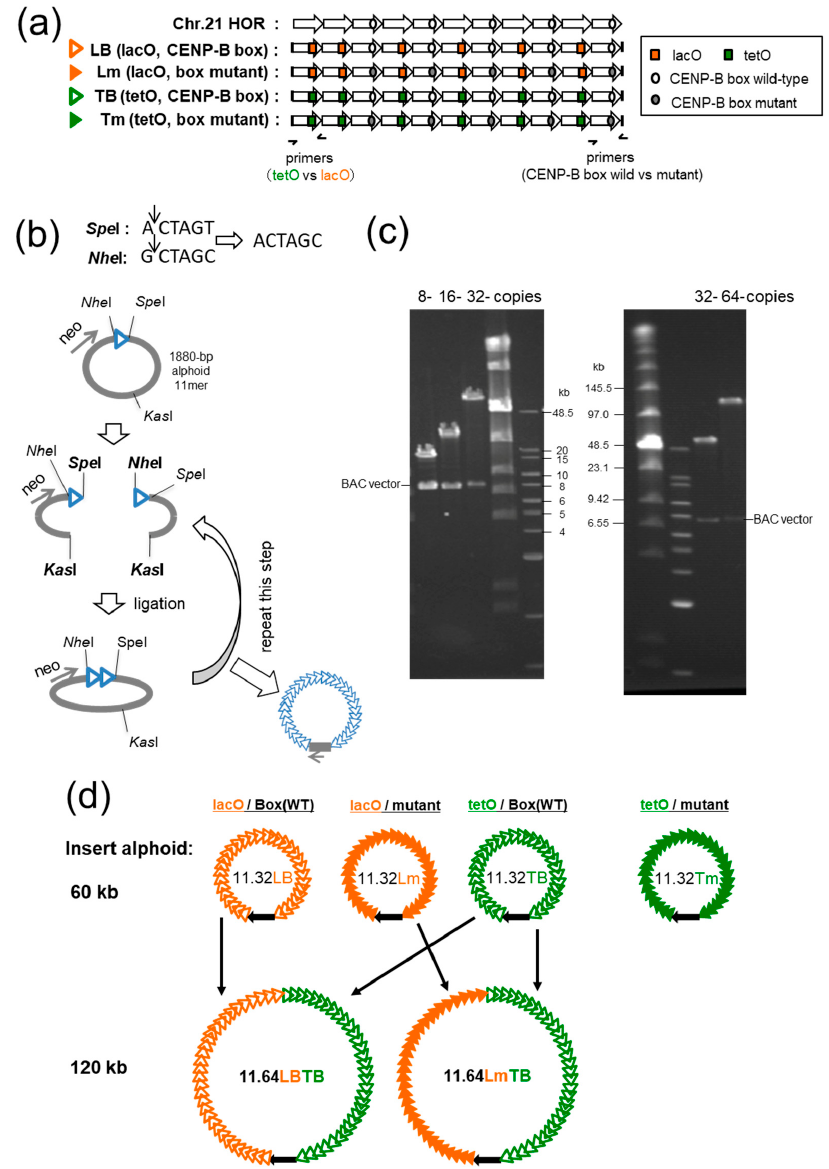
Figure 1. System for chromatin analysis of HACs with two synthetic alphoid repeats. ( a ) Synthetic alphoid design. Four synthetic alphoid sequences were designed based on 1880-bp higher-order repeat (HOR) type I on chromosome 21 (21-I; top) consisting of 11 alphoid repeats, 5 of them containing the CENP-B box sequence (open circle). LB, the lac operator (lacO) sequence (orange square) was introduced into 6 alphoid repeats at the positions corresponding to the CENP-B box. Lm, all 5 CENP-B boxes in LB were mutated (closed circle). TB, the tet operator (tetO) sequence (green square) was introduced instead of lacO. Tm, all 5 CENP-B boxes in TB were mutated. The positions of primers for the competitive PCR are indicated as half arrows. ( b ) Cartoon depicting extending the copy number of 1880-bp HOR units via cleavage and ligation cycles. ( c ) Pulsed-field gel electrophoretic images of the intermediate and final clones digested with Bam HI and NotI to release the insert from vectors. As an example, the left gel shows the TB clone series, and the right gel shows pBAC11.32LB and pBAC11.64LBTB. ( d ) Lineup of the synthetic alphoid BAC clones used in this study. Open and closed orange triangles represent LB and Lm repeats, respectively, and open and closed green triangles represent TB and Tm repeats, respectively. BAC vectors are shown as black arrows indicating the direction of neo gene transcription. Combination used to obtain BAC clones with a 120-kb insert are